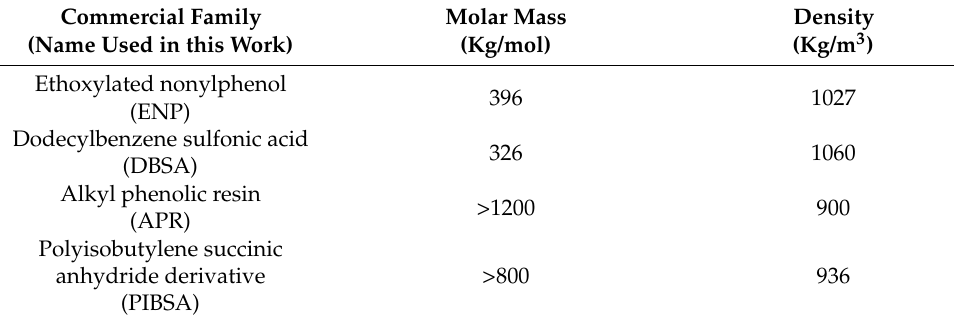
Table 2. Compounds used as